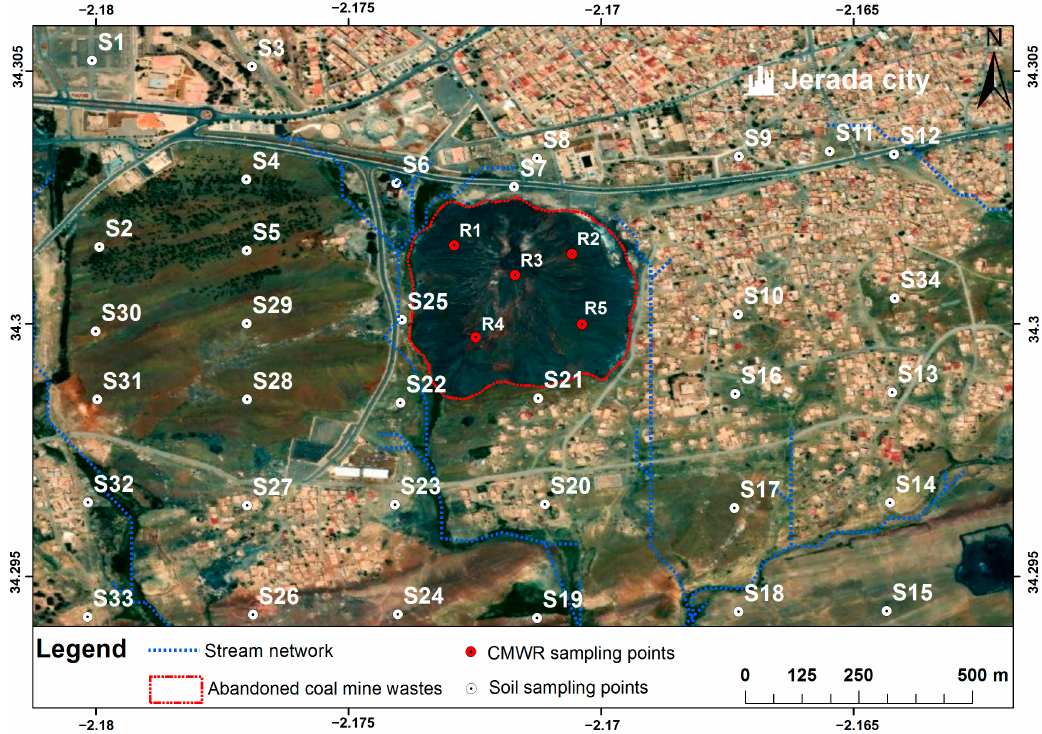
Figure 3. Map of sampling point locations of soil and coal mine waste rocks (Google Earth image modified).